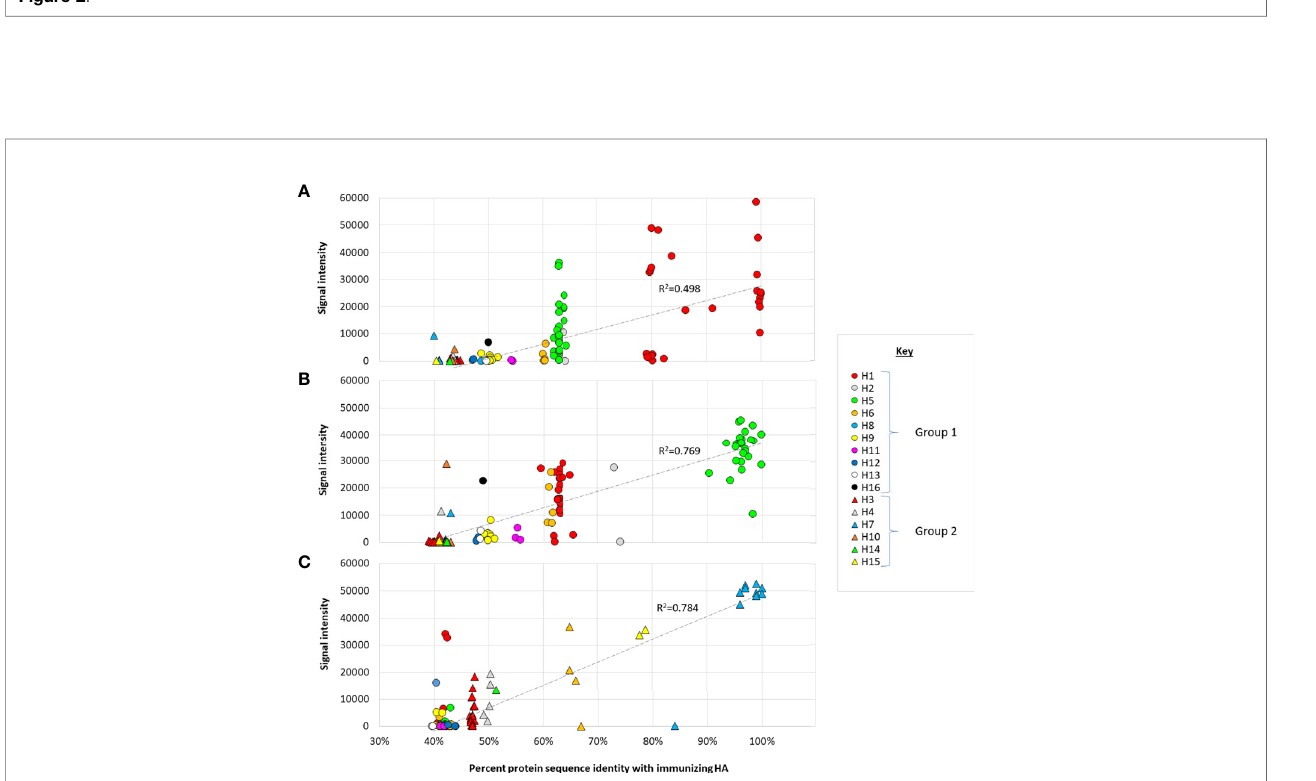
FIGURE 4 | Cross-reactivity as a function of sequence identity. Scatter plots of IgG array signals after single-dose administration full-length (A) Cal09 H1; (B) VN04 H5; (C) AH13 H7, as shown in Figure 2 (d28), plotted against % amino acid identity full-length proteins on the array. Circles, group 1 HAs; triangles, group 2 HAs. Hashed line, linear trend-line fi tted through all data